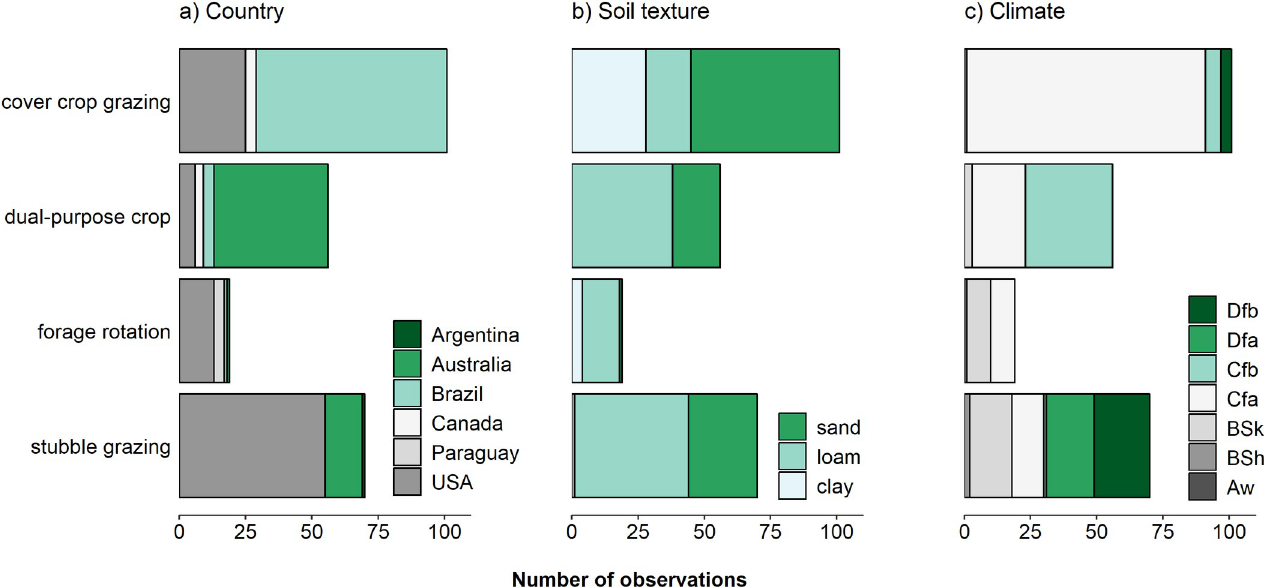
Fig 2. Graphical summary of studies used in the meta-analysis. Shown are the number of observations within Integrated Crop-Livestock System types by (A) country, (B) soil texture, and (C) climate. Ko¨ppen climate class abbreviations are as follows: Aw = tropical savannah; BSh = hot semi-arid; BSk = cold semi-arid; Cfa = humid subtropical; Cfb = temperate oceanic; Dfa = hot-summer humid continental; Dfb = warm-summer humid continental.